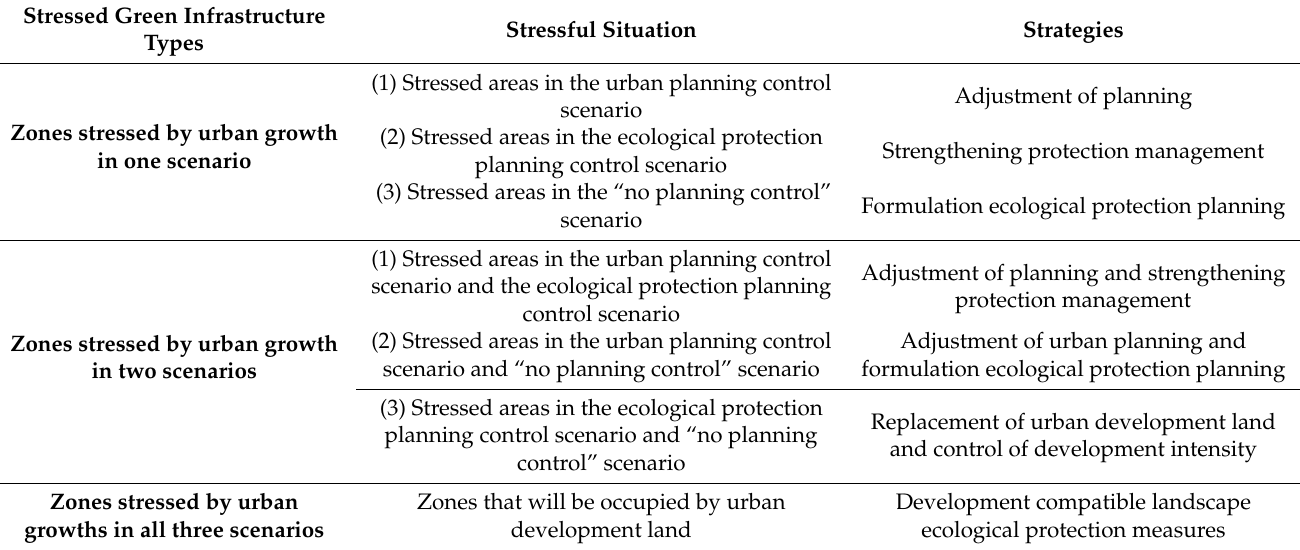
Table 4. Stressed green infrastructure types and